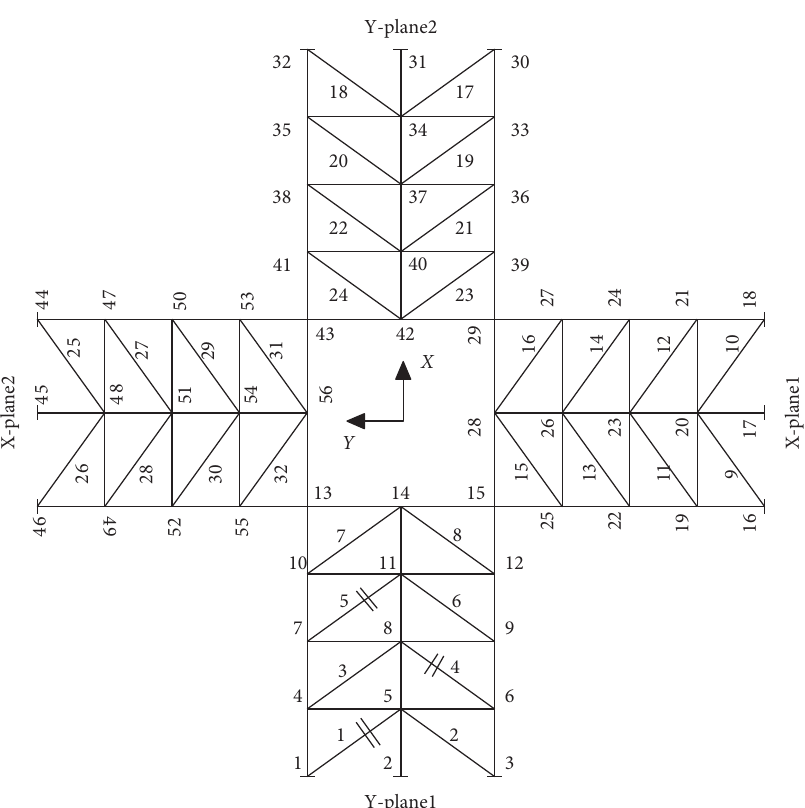
Figure 5: Diagram of the element and node number.